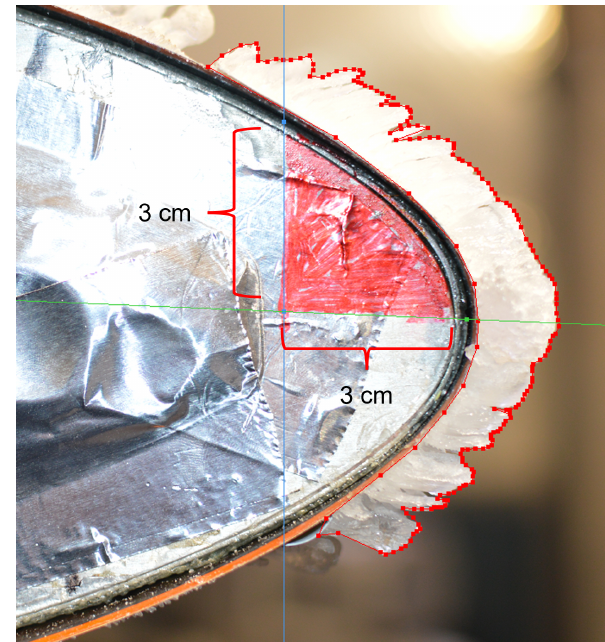
Figure 8. Digitized ice shape at − 8 ◦ C with 0.4g/m 3 LWC. per Eqs. (1) and (2).